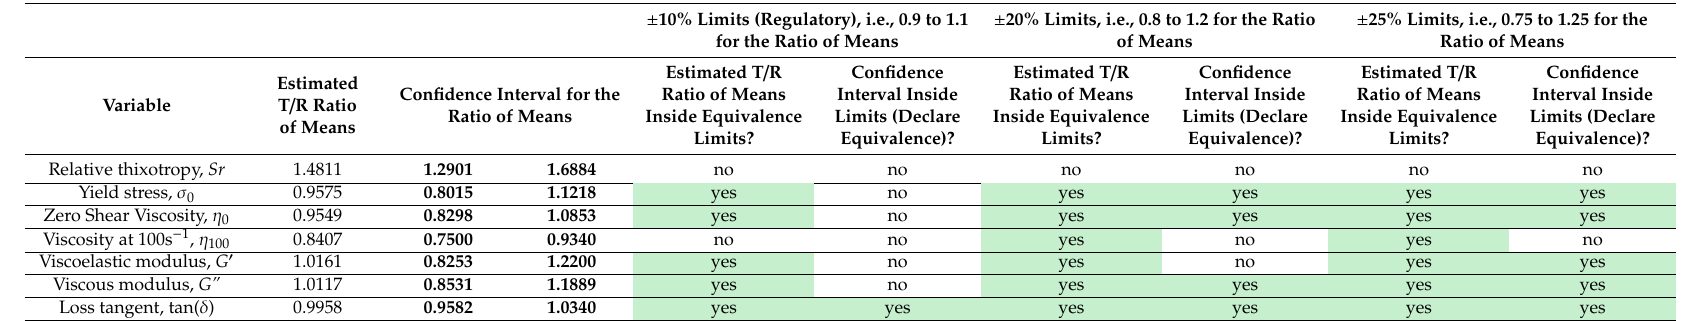
Table 1. Equivalence analysis of the generic form (Test) vs. brand product (Reference). Each rheological parameter is treated separately. Estimated Confidence Interval for the Variable T / R Ratio Ratio of Means of Means